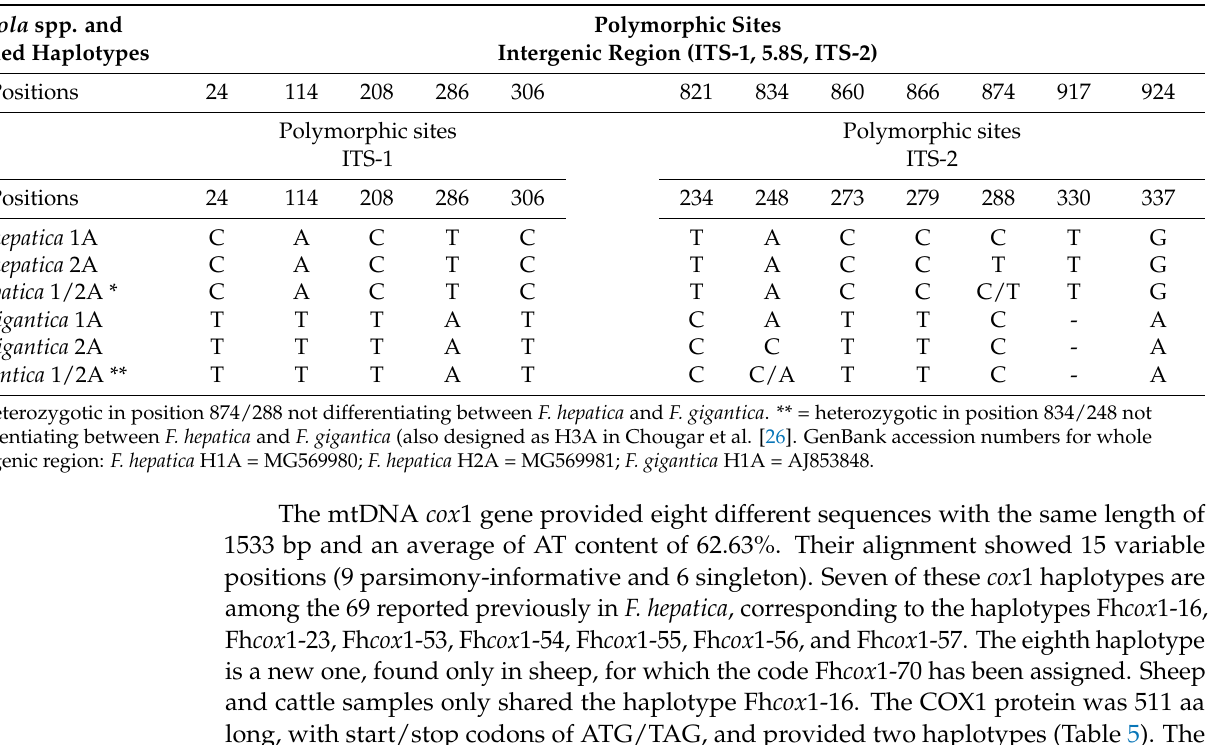
Table 4. Polymorphic sites in sequence comparison of the nuclear rDNA whole intergenic region and in the ITS-1 and ITS-2 between haplotypes of Fasciola hepatica from Ecuador and haplotypes of genetically “pure” F. gigantica from African countries. Fasciola spp. and